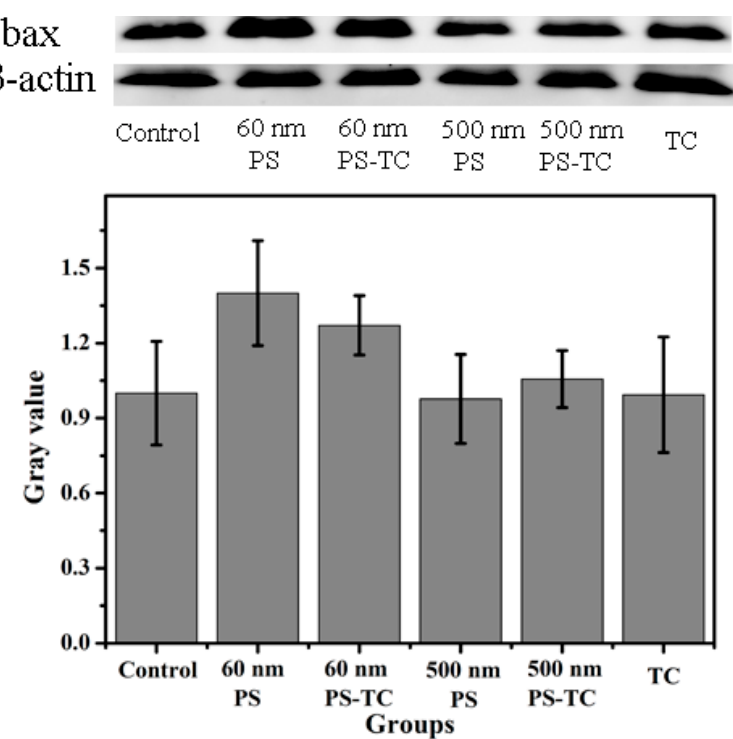
Figure 8. Apoptosis protein expression. The expression level of Bax protein in all groups (60 nm PS-NPs, 60 nm PS-TC NPs, 500 nm PS-MPs, 500 nm PS-TC MPs, TC).